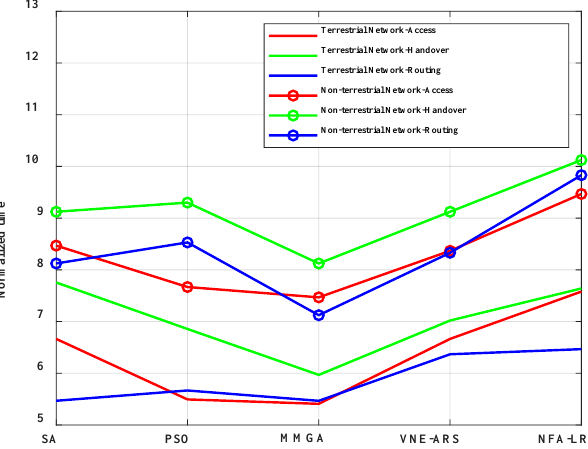
Figure 7. The CPU, memory, and bandwidth normalized utilization of different algorithms under access, handover, and routing behaviors in the terrestrial network and the non-terrestrial network.